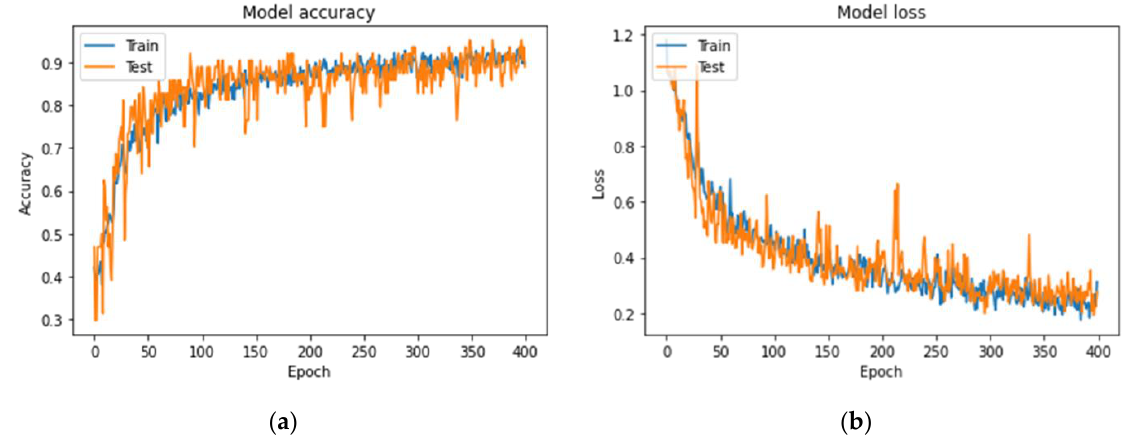
Figure A1. Plots demonstrating the best RGB-CNN for the CAD classification problem: ( a ) Accuracy and ( b ) loss.